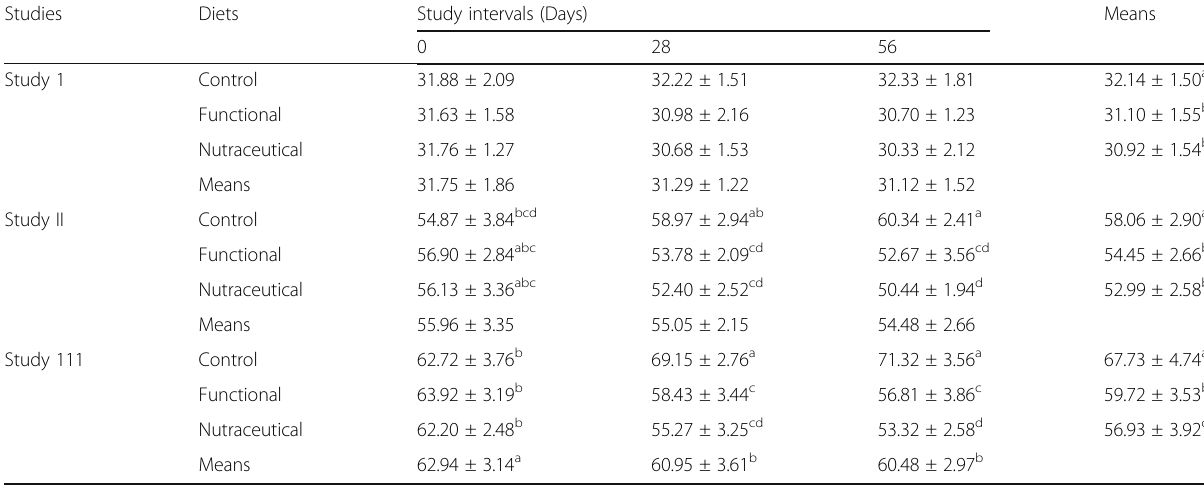
Table 6 Effect of diets and study intervals on LDL-c (mg/dL) of rats in different studies Studies